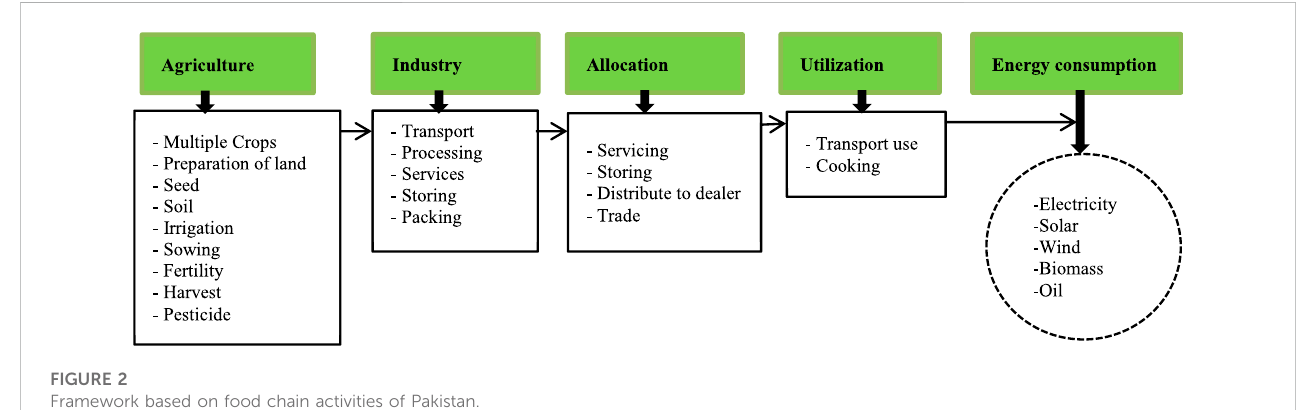
FIGURE 2 Framework based on food chain activities of